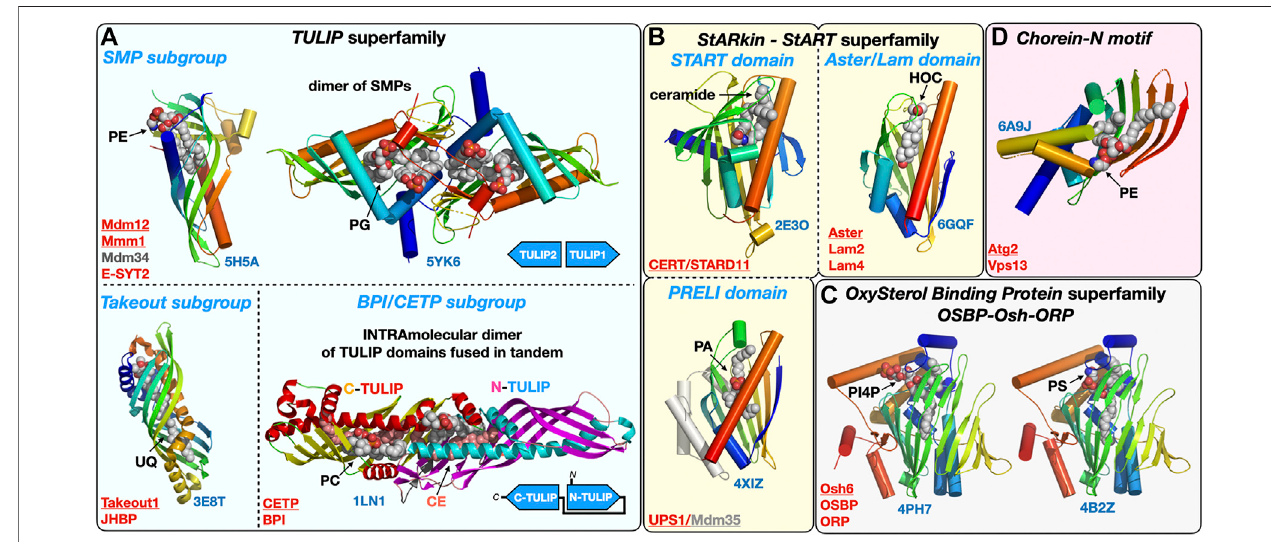
FIGURE 3 | Structural gallery of protein folds and domains observed in lipid-transfer proteins. (A) TULIP protein superfamily representatives within the three subgroups: The SMP domain found in ERMES subunits Mdm12, Mmm1 and Mdm34 and in Extended Synaptotagmins (E-SYT)/Tricalbins (Tcb); the structures of the SMPdomainsfromMdm12andMmm1(dimer)areshown.TheTakeoutandBPI/CETPsubgroups. (B) StARkinproteinsuperfamilywithStARTandStART-likedomains represented by the ceramide transporter CERT/STARD11 and the sterol-binding Aster/Lam proteins, respectively, and also including the PRELI domain represented by the Ups1/Mdm35 PA shuttle in the mitochondrial intermembrane space. (C) OxySterol Binding Protein superfamily including Osh and ORP proteins, Osh6 is represented bound to the two lipids (PS and PI4P) it counter-exchanges at ER-PM junctions. (D) . Chorein-N motif found in proteins Vps13 and Atg2 involved in bulk lipid transfer at several MCSs and the autophagosome, respectively. The motif present in the Atg2 N-terminal fragment crystal structure was observed bound to a PEmolecule. Ligands arerepresented withspheres.Proteinsarecoloredwitharainbowpatternexcept fortheCETP/BPI protein wherethetwoTULIPdomains present in tandem are colored differently to highlight the head-to-head intramolecular arrangement of the two TULIP domains. UQ, ubiquinone; CE, cholesteryl-ester; PI4P, phosphatidyl-inositol 4-phosphate; HOC, hydroxycholesterol. Underlined names correspond to the displayed structures (PDB 5H5A-5YK6-3E8T-1LN1-4XIZ-2E3O-